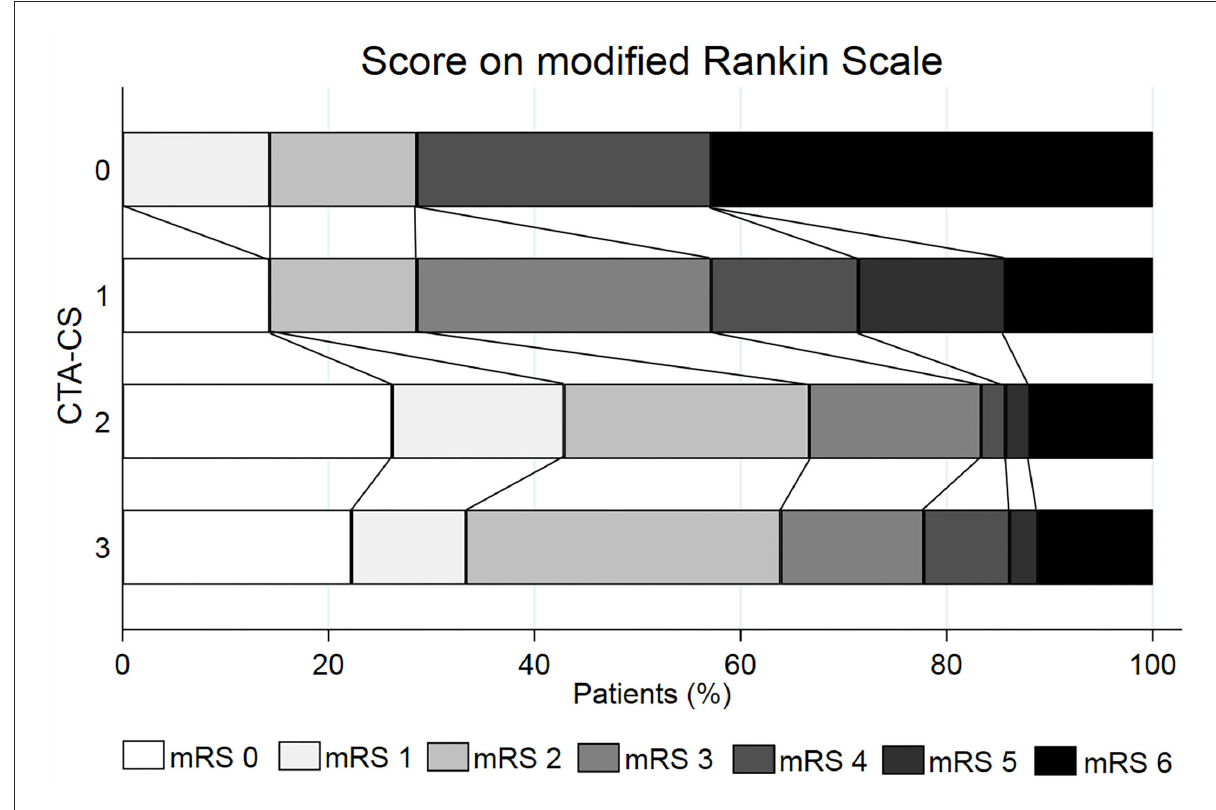
FIGURE2 Distribution of the mRS score at 3 months according to the baseline automated determined Collateral Score